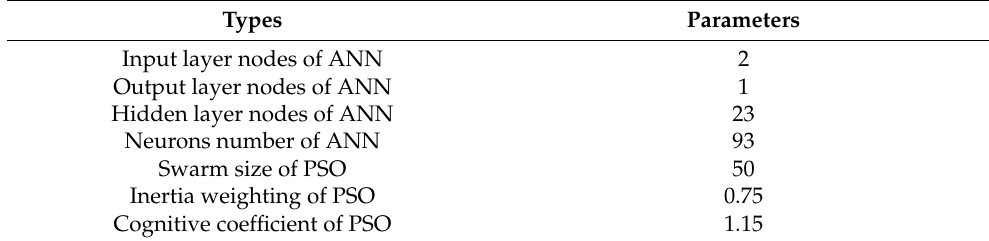
Table 3. The parameters of an optimal ANN.